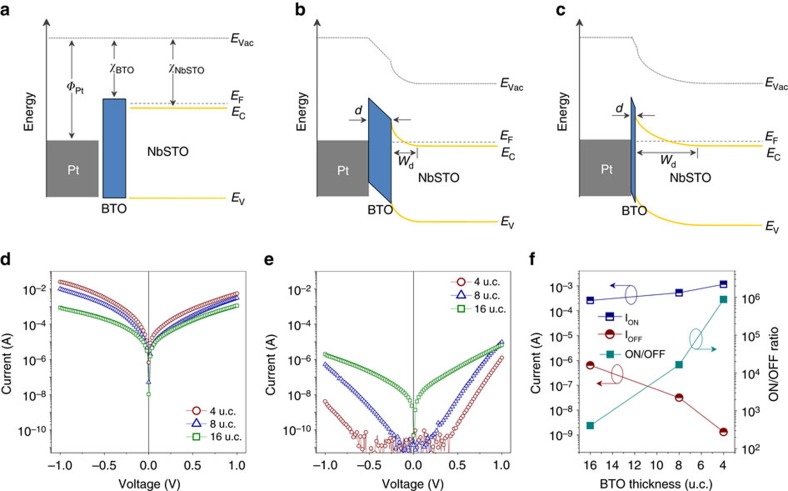
Tunnelling electroresistance of Pt/BaTiO3 (BTO)/Nb:SrTiO3 (NbSTO) ferroelectric tunnel junctions with various BTO thickness.Band diagram of separated Pt, BTO and NbSTO (a) and of Pt/BTO/NbSTO junction with a thick (for example, 16 u.c.) (b) and a thin (for example, 4 u.c.) BTO barrier (c), where ΦPt=5.65 eV is the work function of Pt, χBTO=3.9 eV the electron affinity of BTO, χNbSTO=4.08 eV the electron affinity of NbSTO, EVac the vacuum level, EC, EV and EF the conduction band minimum, the valence band maximum and the Fermi level of NbSTO, respectively, d the BTO thickness, Wd the depletion region width. (d,e) I–V curves of Pt/BTO/NbSTO (Nb: 0.7 wt%) FTJs, with a BTO thickness of 4, 8 and 16 u.c., in the ON and the OFF states, respectively. (f) Junction currents and corresponding ON/OFF ratios, read at 0.6 V, as a function of BTO thickness.